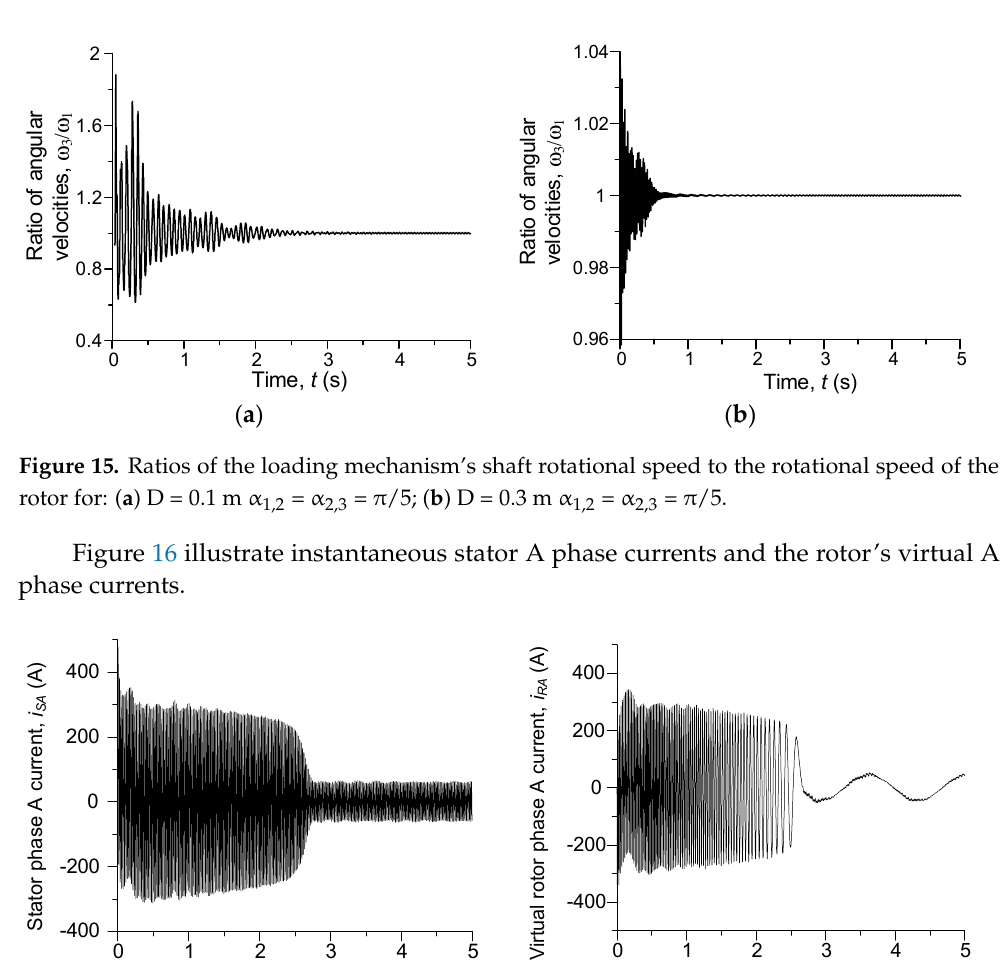
( b ) Figure 14. Spatial–temporal waveforms of moment of torsion across the shaft for: ( a ) t ∈ (0.34; 0.42) D = 0.1825 m α 1,2 = α 2,3 = π /5; ( b ) t ∈ (2.72; 2.80): D = 0.3 m α 1,2 = α 2,3 = π /5. In Figure 14a, D = 0.1825 m, α 1,2 = α 2,3 = π /5. In Figure 14b, D = 0.3 m, α 1,2 = α 2,3 = π /5. Analysis of the 3D graphs clearly shows the highly complicated processes in the middle susceptible shaft with distributed mechanical parameters. The angular velocities and ro- tation angles of the shaft’s spatial discretisation nodes change in line with the laws of